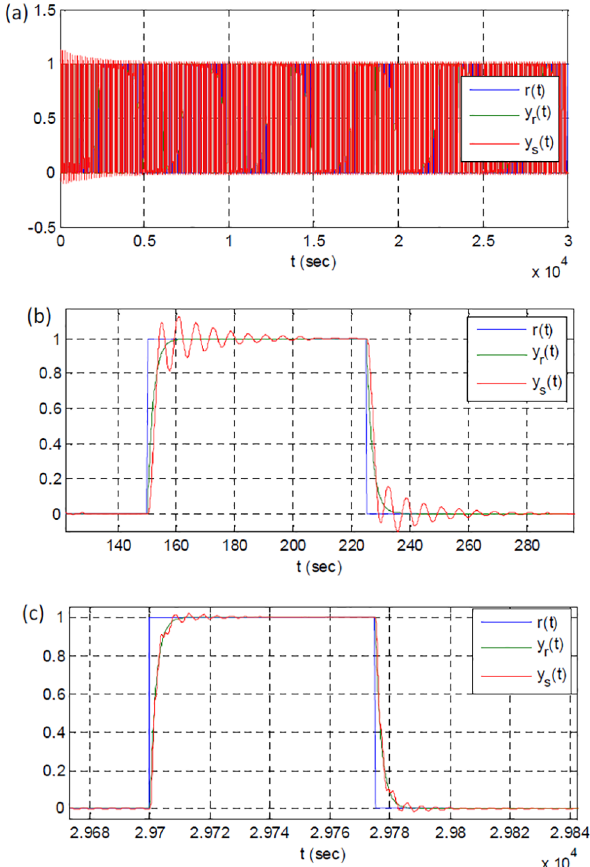
Fig 3. The reference input, outputs of the reference model and the plant: (a) a view of full-time simulation, (b) a close view of initial responses, (c) a close view of final responses.